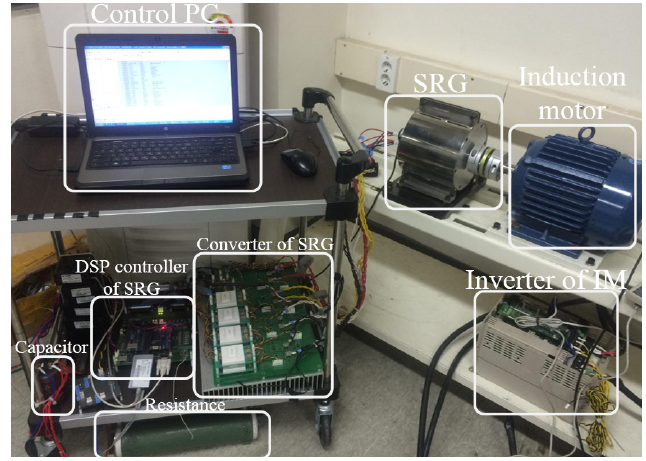
Figure 14. Experimental setup of SRG